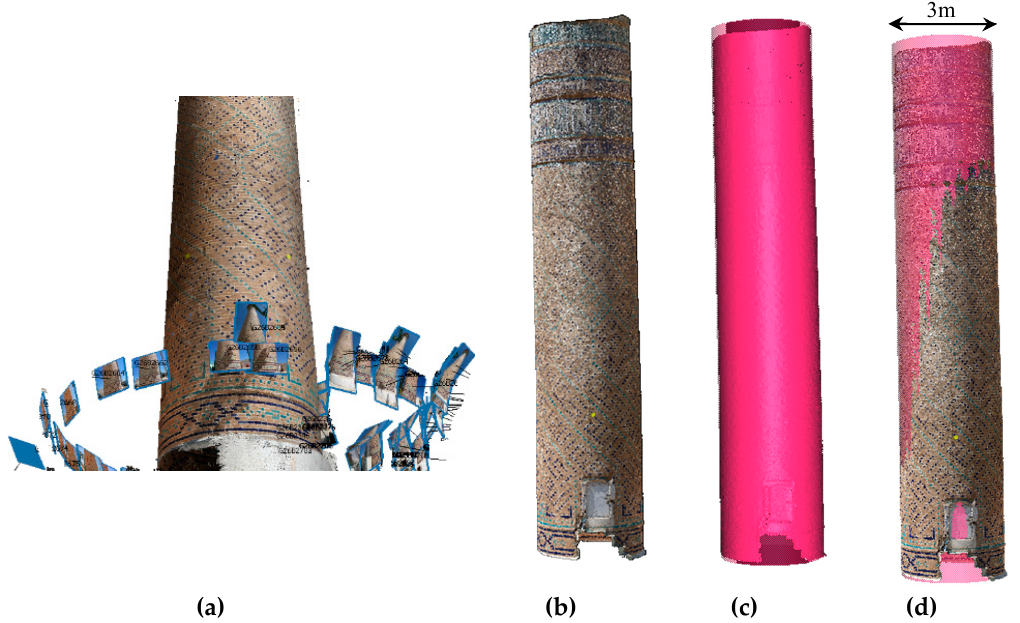
Figure 9. The produced image-based point cloud of the shrine minaret. ( a ) Minaret body with the oriented images around it. ( b ) Dense point cloud of the minaret. ( c ) Best fitting cylinder. ( d ) Fitting cylinder fused with the point cloud.